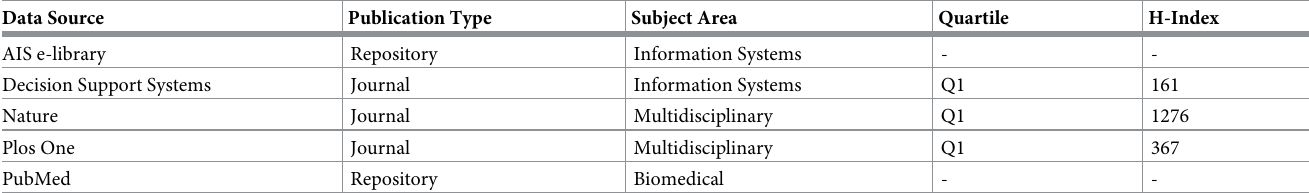
Table 1. Information of selected data sources. Source: Scimago Journal and Country Rank via www.scimagojr.com, accessed on May 13,